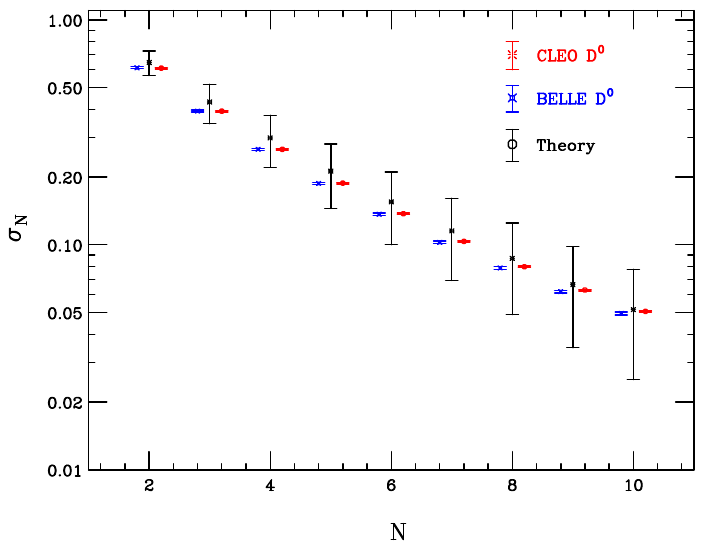
Figure 7. As in Fig. 6, but comparing the effective-coupling prediction with the BELLE and CLEO Figure 7. As in Figure 6, but comparing the effective coupling prediction with the BELLE and CLEO Version September 10, 2022 submitted to Universe moments on D 0 production. moments on D 0 production.